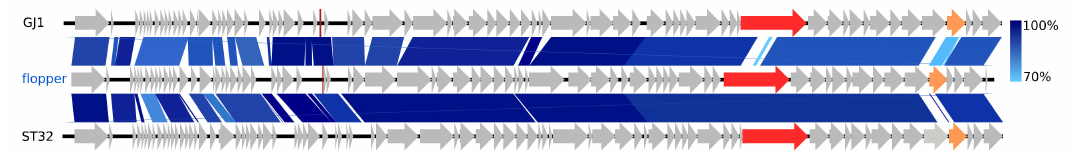
Figure 4. Pairwise alignment of the new Carltongylesvirus phage flopper (blue) and the Carltongylesvirus phages GJ1 and ST32; the colour bars between genomes indicate percent pairwise similarity (Easyfig, BlASTn). Genomes have been modified to have similar starting points. Genes coding for the putative tail tape measure protein (red) and a tail fiber (orange) are